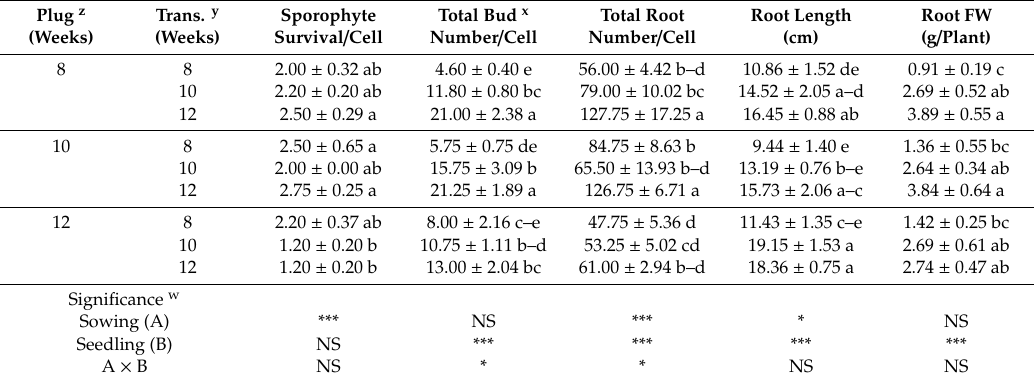
multiple range test. z Young sporophyte obtained after sowing, according to the period of plug seedling. y The sporophyte grown after transplanting the young sporophyte obtained from the plug